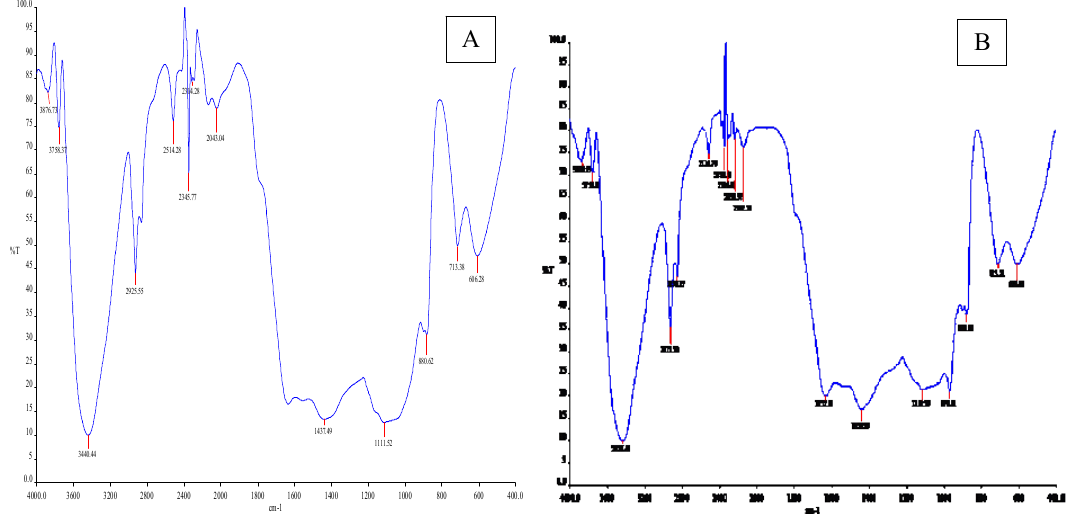
Fig. 4. FTIR analysis of MWCNT nanoparticles (A) and MWCNT/NBR nanocomposite (B)